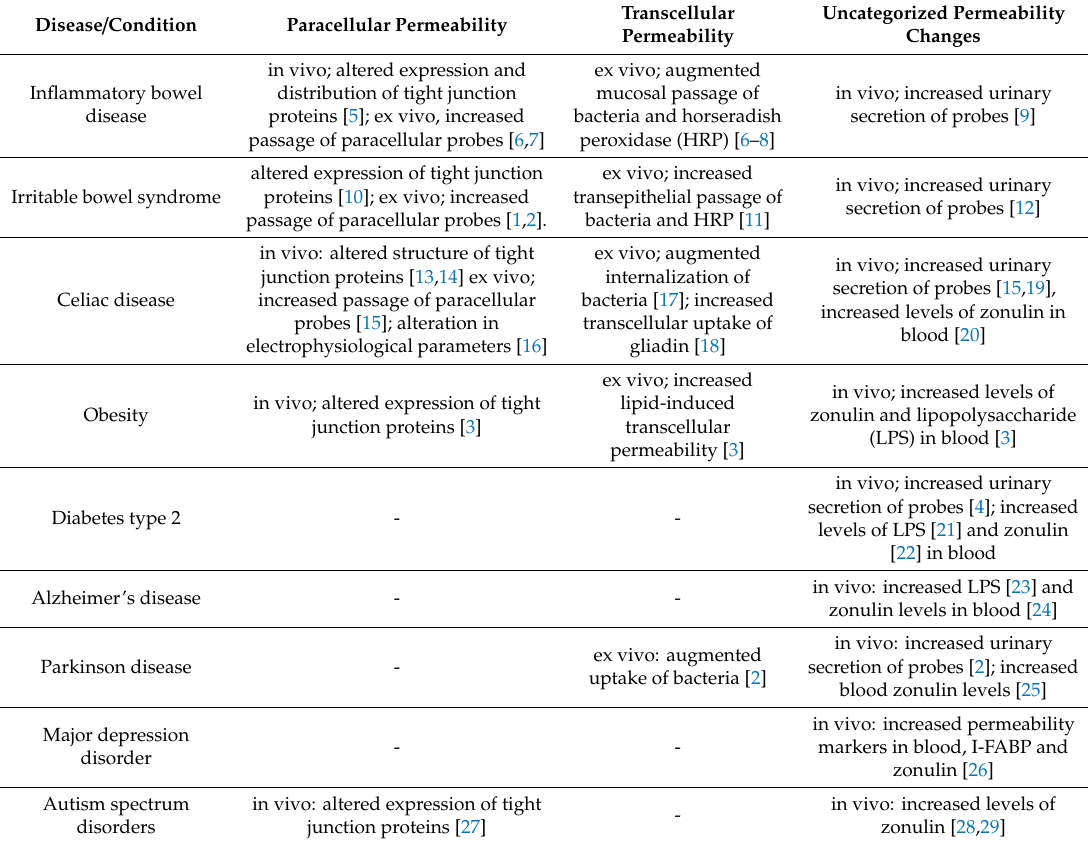
Table 1. Major diseases and conditions associated with an increased intestinal